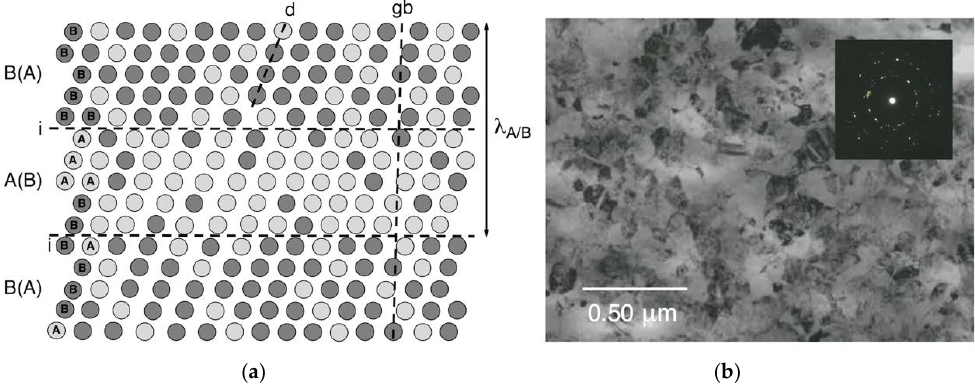
Figure A1. The A/B nanolaminate structure with A (dark-shaded atoms) and B (light-shaded atoms)